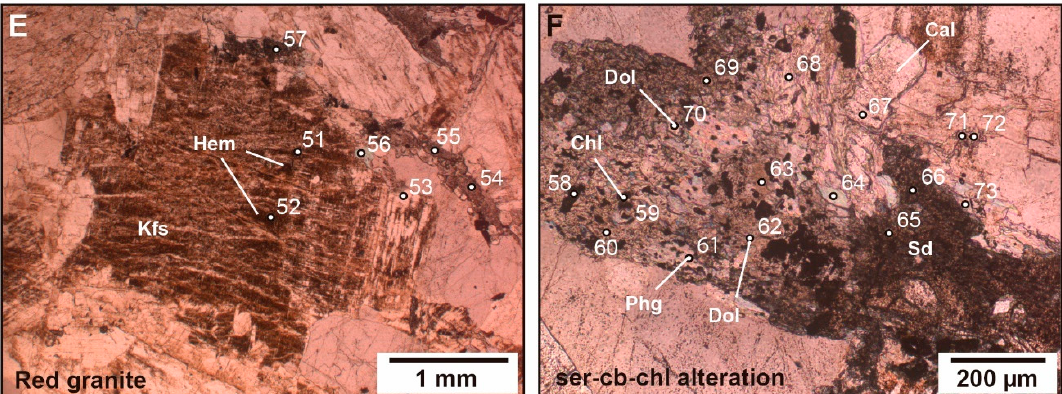
Figure 12. Thin section photomicrographs of SCC alteration minerals of the Passa Três granite analysed by EPMA: ( A ) Chlorite replacing magmatic biotite; ( B ) Mafic aggregate in red granite formed by biotite and altered amphibole; analytical points indicate the presence of clinochlore, siderite (Fe(Mg) carbonate), Fe-dolomite (Ca-Mg-Fe carbonate), and calcite as alteration minerals; ( C ) Fe-dolomite (Ca-Mg-Fe carbonate) and siderite (Fe(Mg) carbonate) as alteration in the red granite; ( D ) Relic sphene crystal altered to siderite (Fe(Mg) carbonate), phengite, Fe-dolomite (Ca-Mg-Fe carbonate), and rutile, SCC alteration; ( E ) K-feldspar with Fe-oxide exsolution as indicated by the presence of FeO in the EPMA analysis; ( F ) Biotite replaced by clinochlore, calcite, Fe-dolomite, siderite, sericite (phengite), with indication of the points of analyses. Images ( A – F ): optical microscope—